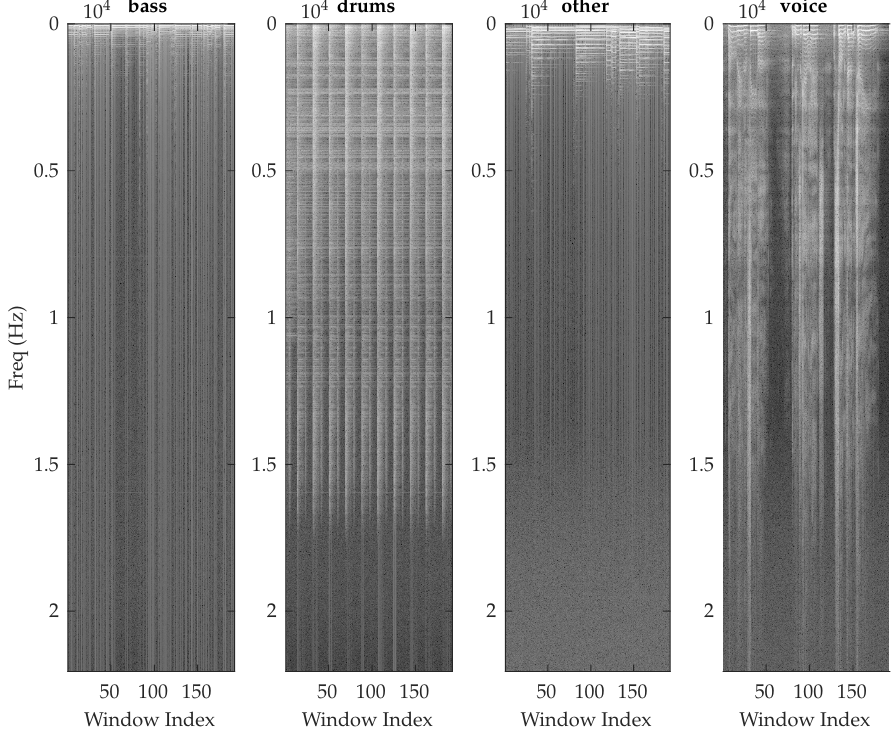
Figure 10. TF Sources Original: bass (column 1), drums (column 2), other instruments (column 3), voice (column